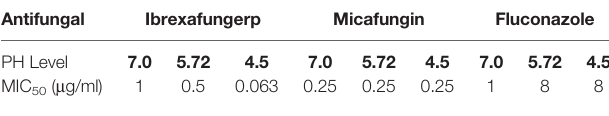
TABLE 2 | In vitro activity of ibrexafungerp and comparators in lower pH environments (Dodds Ashley et al.,